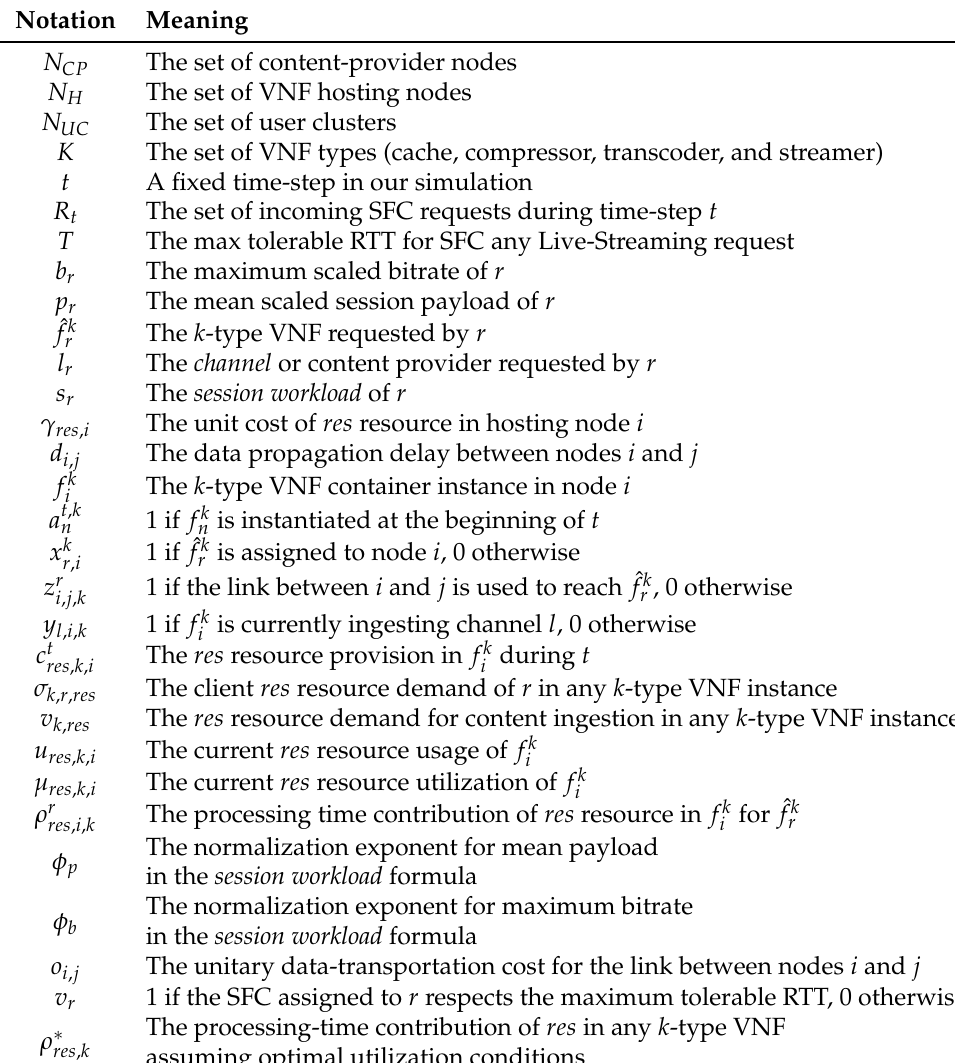
Table 1. Key notations for our vCDN SFC Deployment